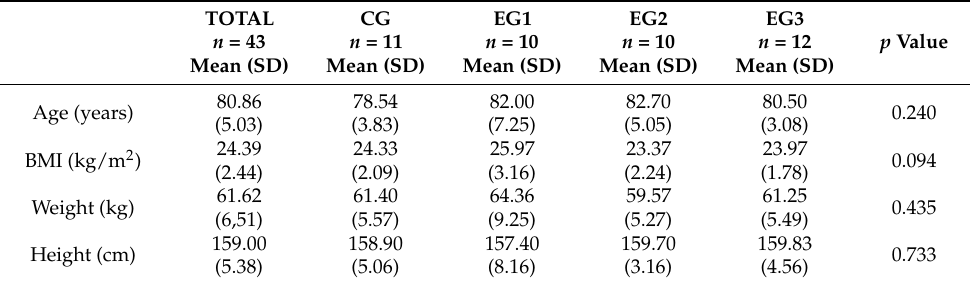
Table 1. Age, and anthropometric characteristics of the